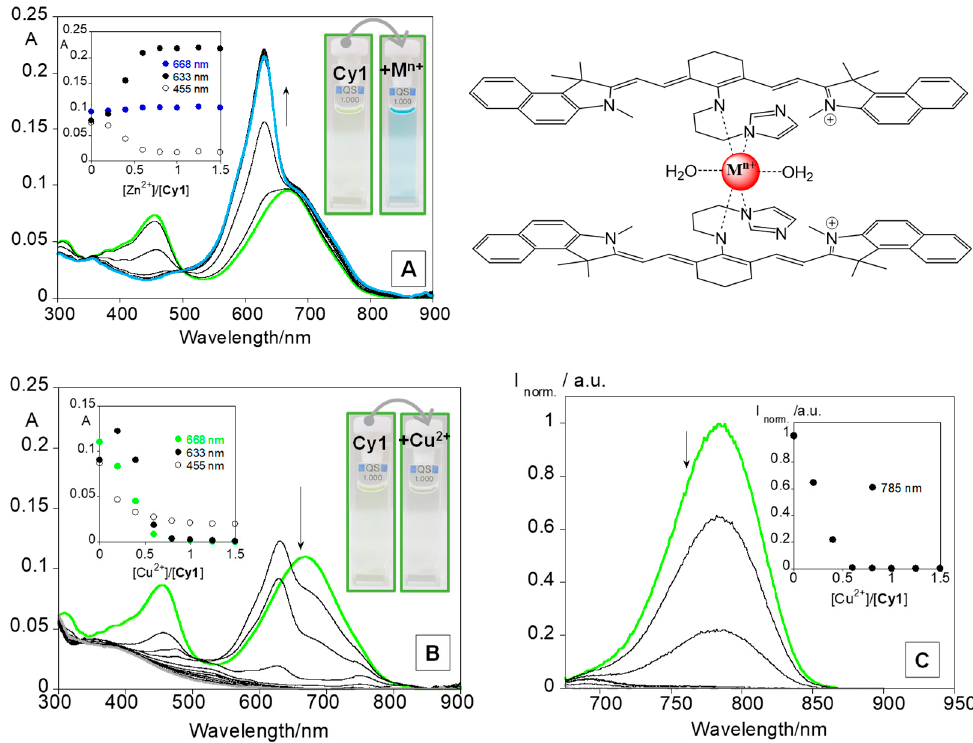
Figure 2. Spectrophotometric ( A , B ) titrations of dye Cy1 with the addition of Zn 2+ and Cu 2+ in acetonitrile. The inset ( A , B ) represents the absorption at 455 nm, 633 nm and 668 nm, as function of [Zn 2+ ]/[ Cy1 ] and [Cu 2+ ]/[ Cy1 ], respectively, and the colourimetric changes upon the addition of the different metal ions, Cu 2+ and M n+ : Zn 2+ , Cd 2+ , Co 2+ , Ni 2+ and Hg 2+ . ([ Cy1 ] = 5.8 × 10 − 6 M, λ exc = 668 nm, and T = 295 K). Spectrofluorimetric titration of Cy1 ( C ) with the addition of Cu 2+ in acetonitrile; the inset shows the emission at 785 nm as a function of [Cu 2+ ]/[ Cy1 ]. Proposed structure of the metal complexes for Cy1 .